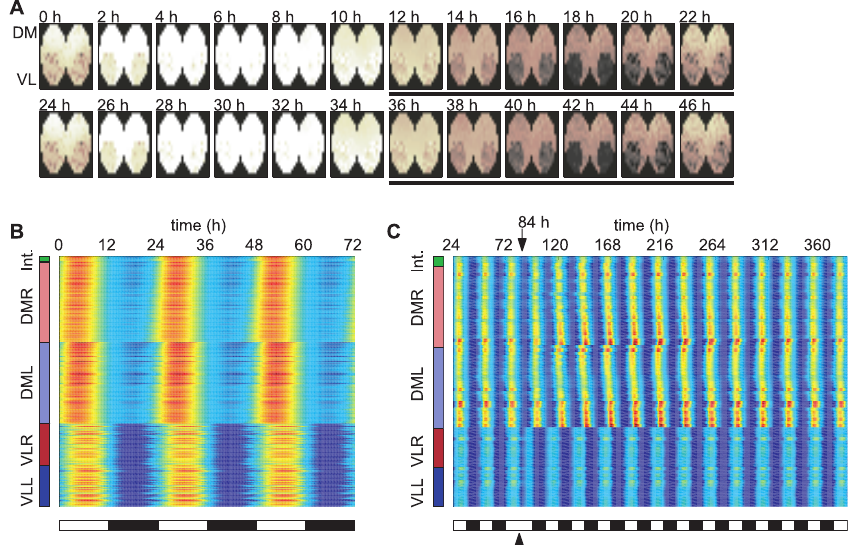
Figure 7. Simulation of Entrainment of a 2-D SCN Slice by a 12:12 LD Cycle (A) Simulation of the evolution of Per/Cry mRNA over 48 h of 309 coupled cells (VL, n ¼ 102; DM, n ¼ 207) in a 2-D SCN slice with a type 3 coupling ( d max ¼ 3.5, 50% of neuronal projections, 4% average period gradient, K ¼ 1.0, L 0 ¼ 0.22). The black bars indicate a dark phase (color code as in Figure 3A). Individual oscillators have an average period of 23.7 6 1.2 h. Initial conditions were chosen randomly. The first 72 h of transient were discarded, and the time from 72 h to 144 h was retained. (B,C) Raster plot of Per/Cry mRNA activity in oscillators, organized according to their regions (from bottom up: VLL, left VL region; VLR, right VL region; DML, left DM region; DMR, right DM region; and Int, intersection between left and right DM regions). The concentration of Per/Cry mRNA for each oscillator is represented by colors (blue, low concentration; red, high concentration). (B) 12:12 LD cycle. (C) 12:12 LD cycle with a 12 h phase shift at t ¼ 84 h.